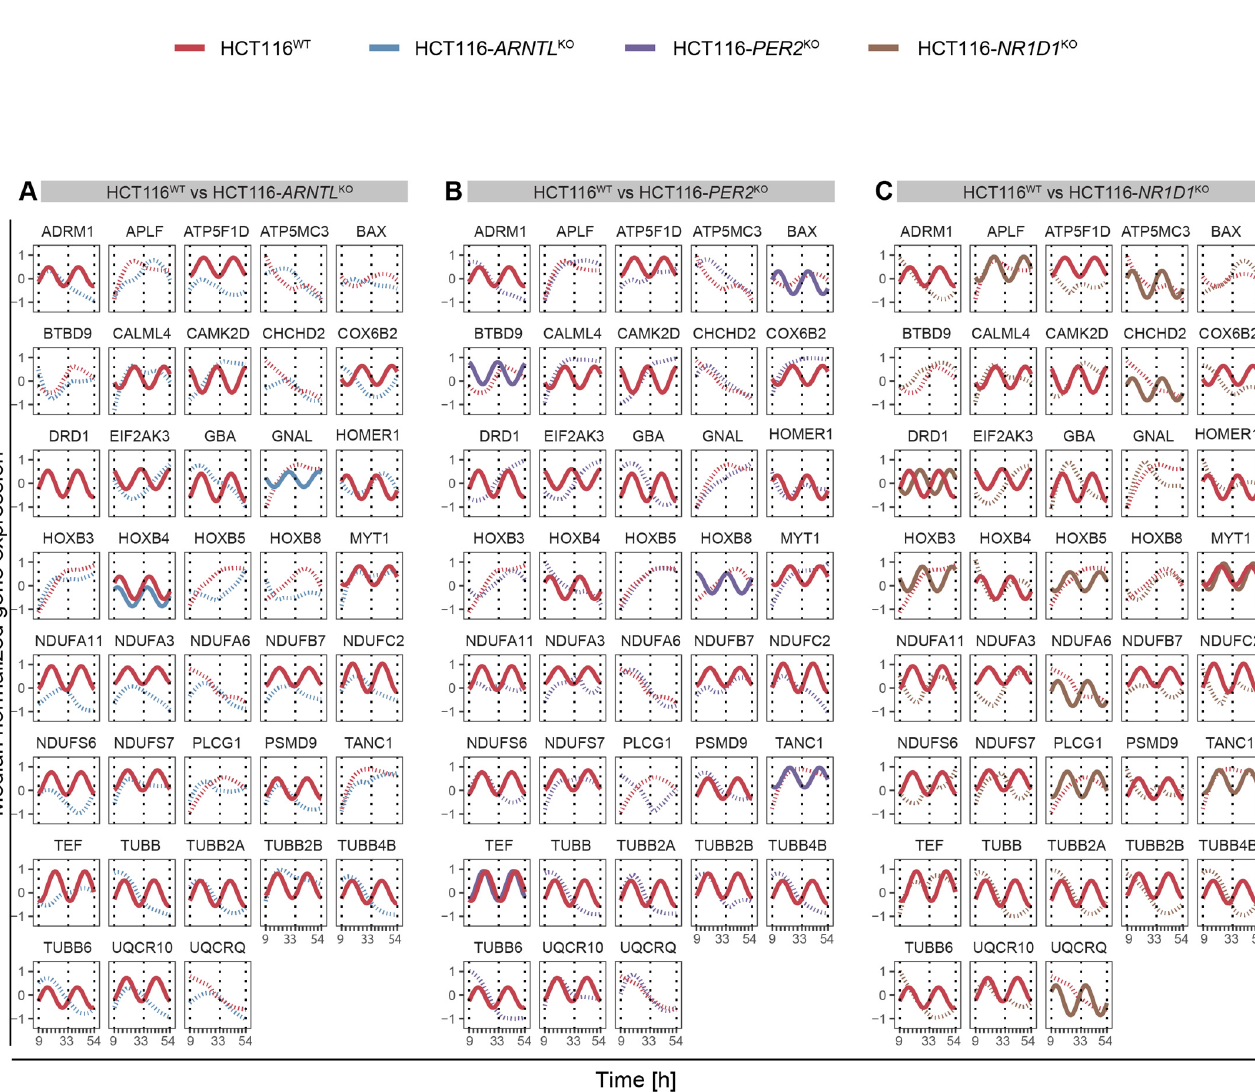
Figure 7. Circadian expression profiles of PD-associated genes. ( A ) in HCT116 WT and HCT116- ARNTL KO ( B ) in HCT116 WT and HCT116- PER2 KO ( C ) in HCT116 WT and HCT116- NR1D1 KO . Rhythmicity analysis was computed considering a 24-h period. Depicted are significantly rhythmic genes ( q < 0.05 and relative amplitude ≥ 0.1) plotted using a harmonic regression fitting (full lines), whereas not significantly rhythmic genes were represented with LOESS (dashed lines) (see Figure S3 for similar analysis in SW480 and SW620